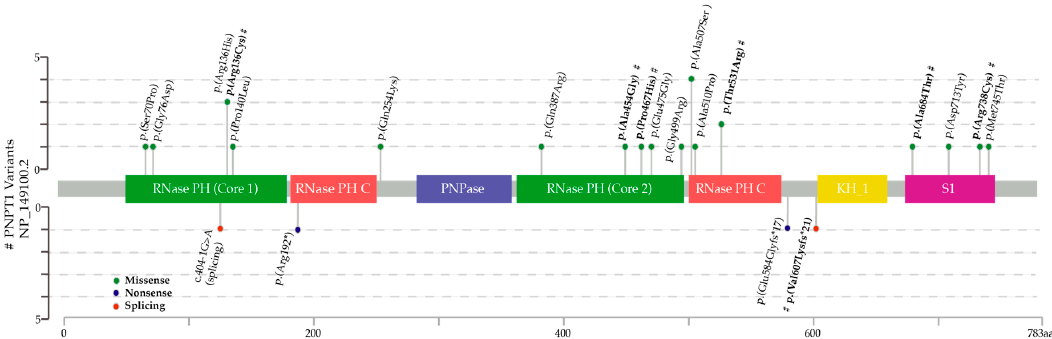
Figure 1. Lollipop plot depicting the polynucleotide phosphorylase (PNPase) protein and location of pathogenic variants reported in 30 alleles (15 families). Missense variants are shown above the protein. Nonsense and splicing variants are shown below. Novel variants reported in this article are marked with #.